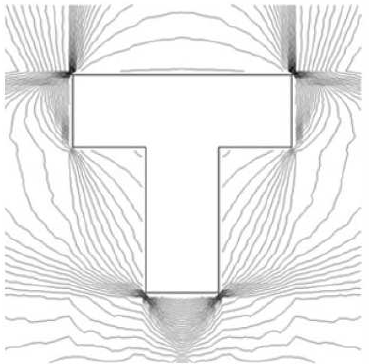
Figure 6. An example of an isovist field of isovist area (Turner et al., 2001).